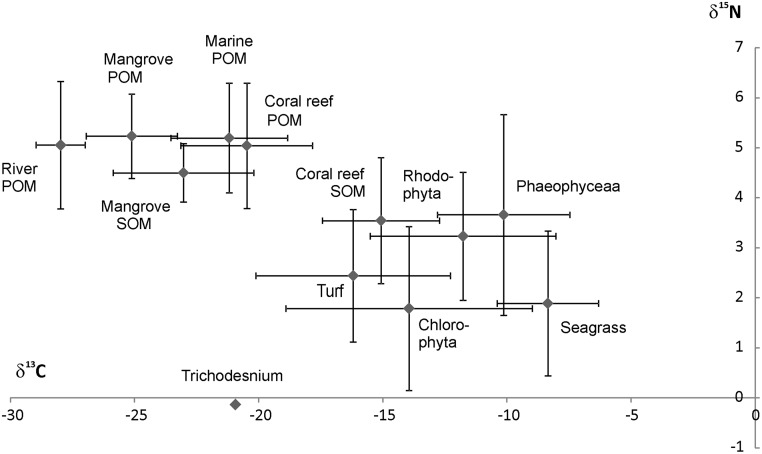
δ13C versus δ15N scatterplot of major OM sources in the SW lagoon of New Caledonia.